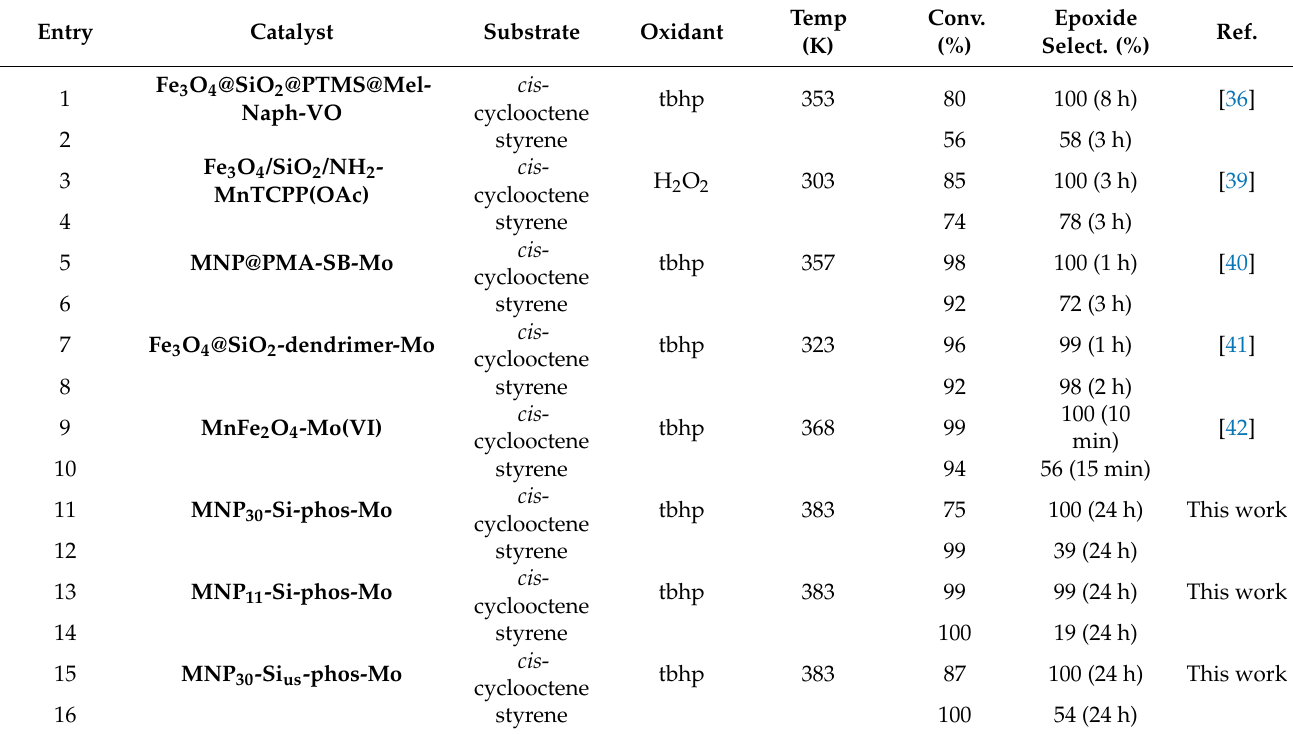
Table 5. Comparison of catalytic performance between this work and previously reported systems from the